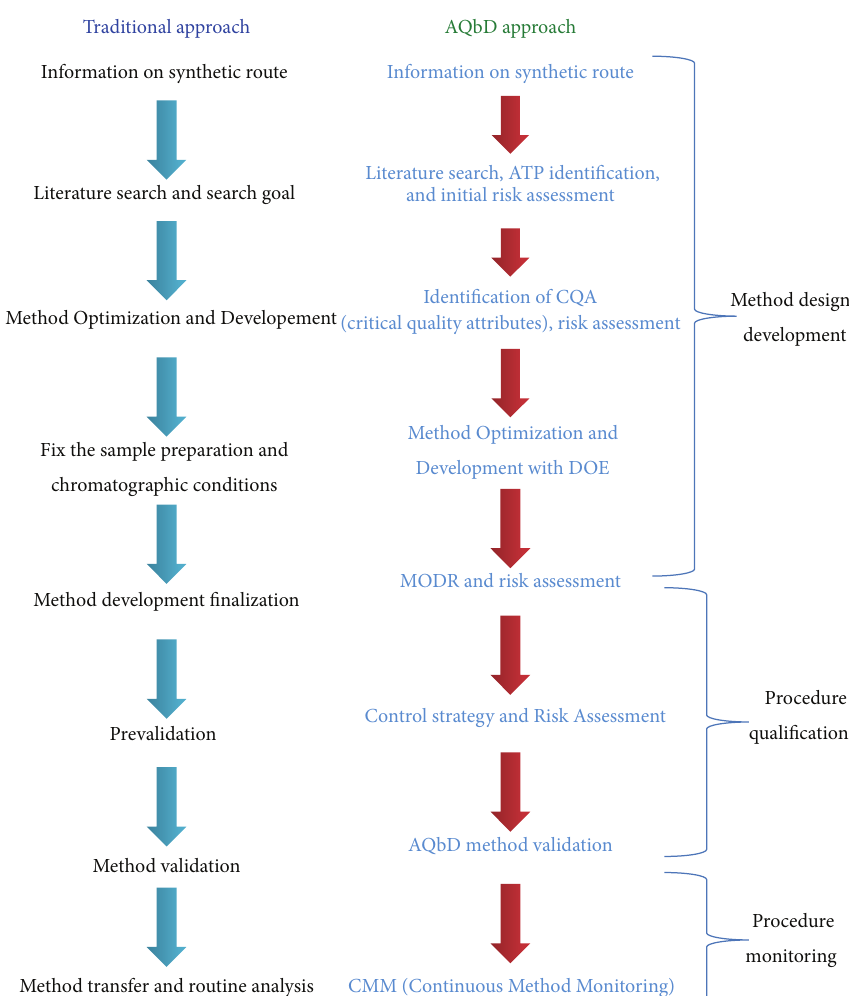
Figure 3: Traditional and AQbD approach for analytical method